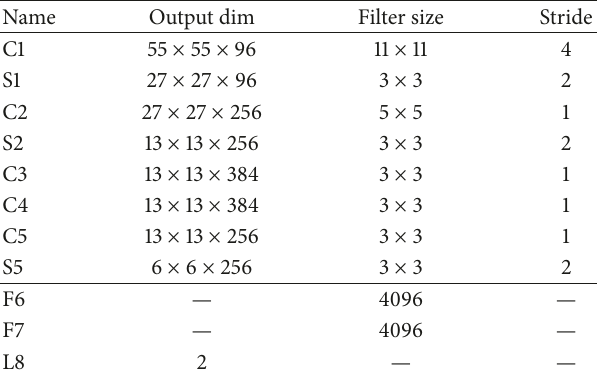
Table1:Thelayerparametersofournetwork. Theoutputdimension in the table is given by height × width × width. All convolution and fully connected layers use Relu activation